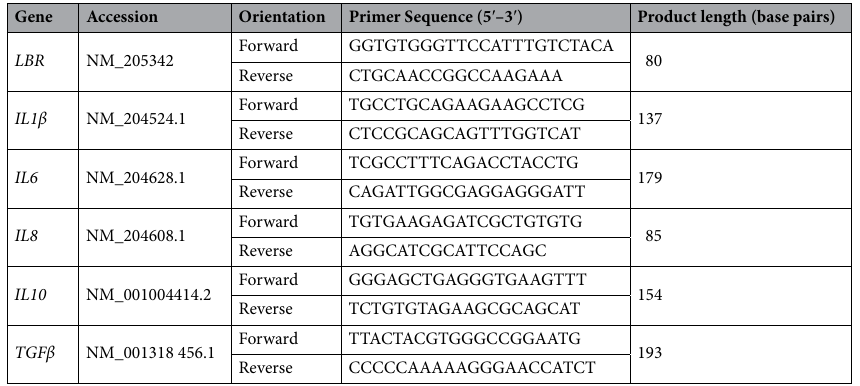
Table 1. Primer sequences employed for quantification of inflammatory cytokine expression in splenic